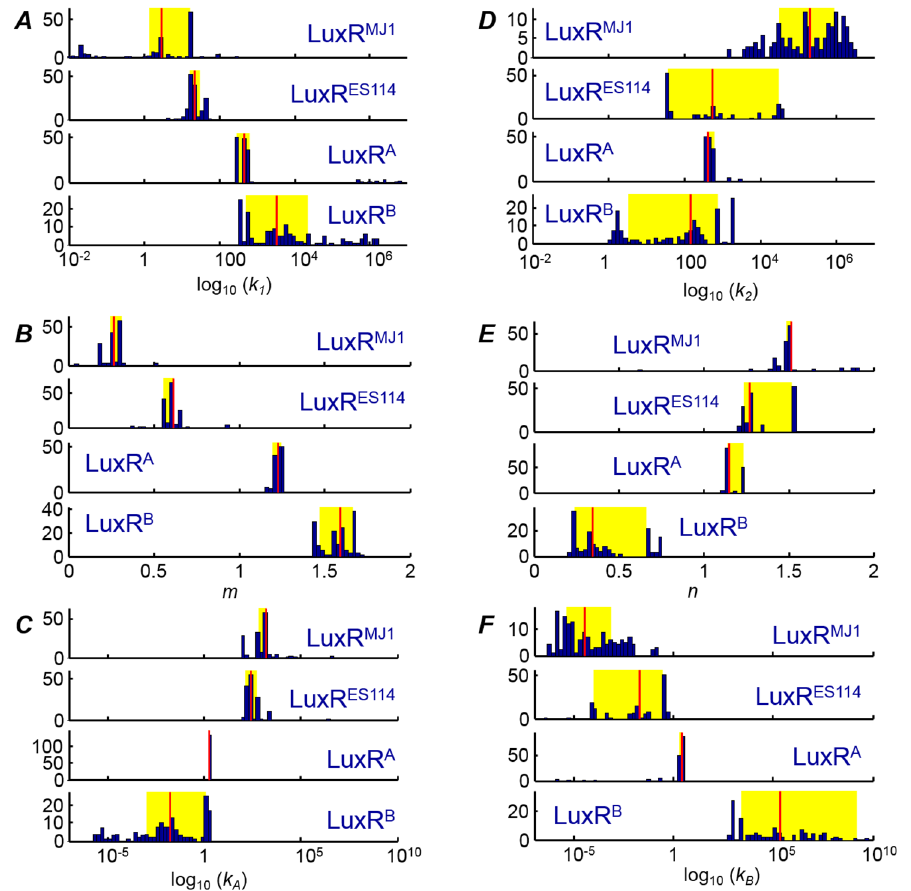
Fig 6. Fit results for the four Δ ainR strains, obtained by fitting luminescence data for each strain to the six-parameter model of Fig 1. For each of four LuxR variants, 150 independent optimizations of the model were performed with respect to three independent luminescence experimental datasets. The histograms below indicate the results obtained for ( A )-( C ) the C8-HSL interaction parameters and ( D )-( F ) the 3OC6-HSL interaction parameters. The red line indicates the median result for a given parameter and LuxR, while the yellow box indicates the span of the 25 th -75 th percentiles for the parameter. The dissociation constants k 1 , k 2 , k A , k B are the scaled (relative to [LuxR 0 ] — see Methods ) dissociation constants and accordingly have units of